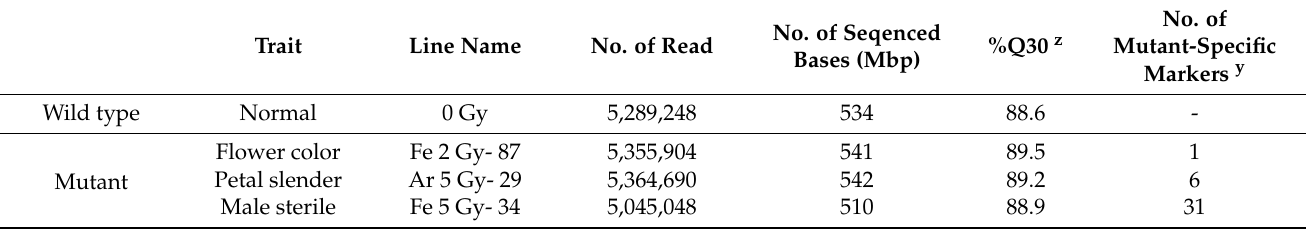
Table 2. Summary of GRAS-Di analysis results for the mutants obtained by ion beam irradiation. Trait